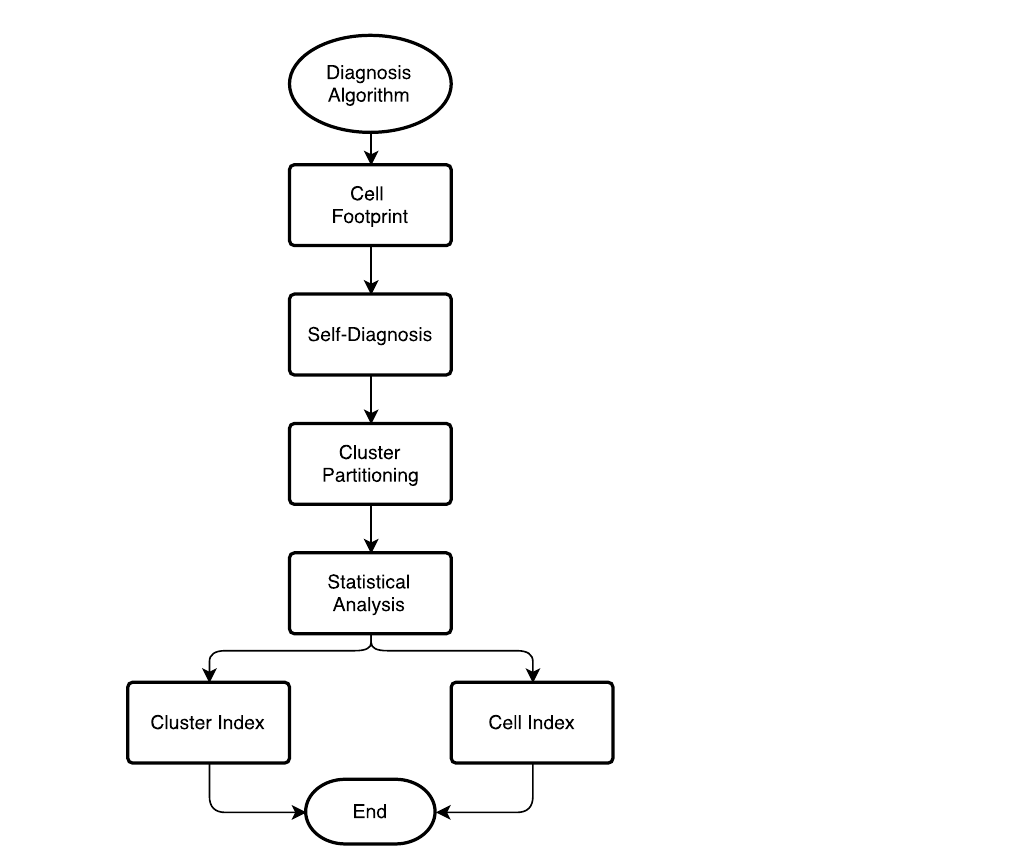
Figure 2. Flowchart for the overshooting, coverage holes and pilot pollution